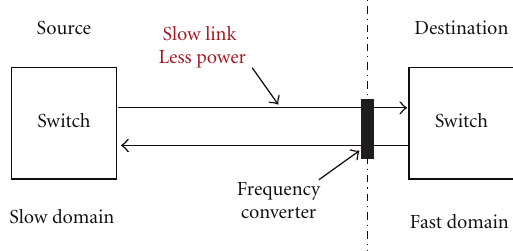
Figure 4: Placed closer to the fast clock domain.